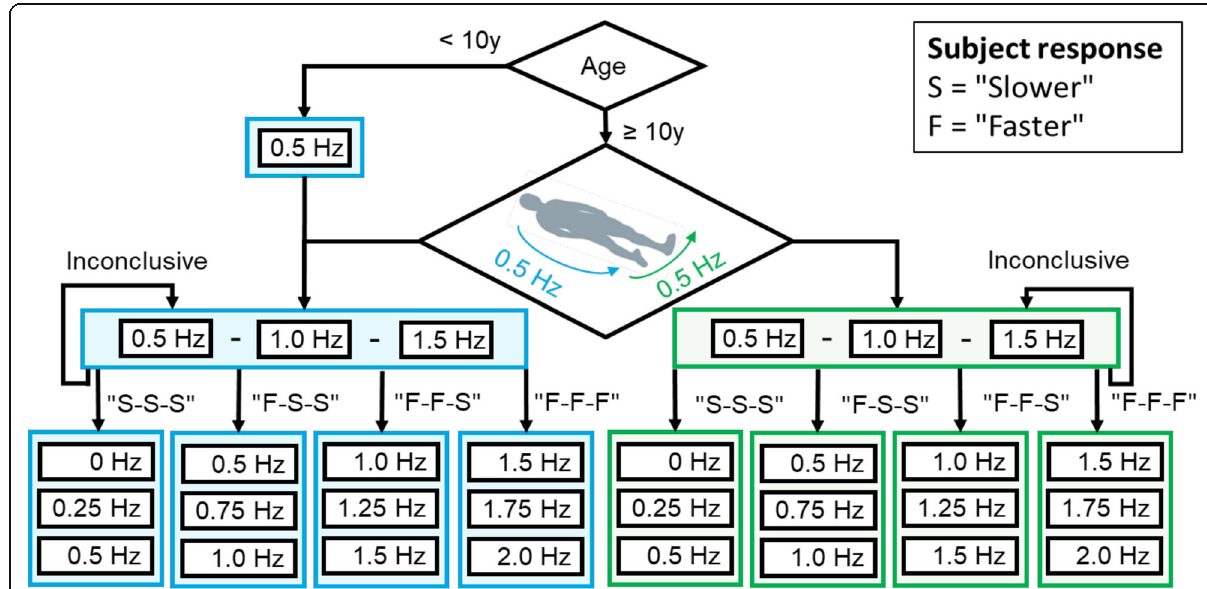
Fig. 1 Stimulation preference selection protocol flow chart. First participants of 10 years and older were presented two motion direction (side-to- side or head-to-toe) while the bed was moving with a frequency of 0.5 Hz, and were asked to choose a preferred direction. For safety reasons participants under 10 years tried only the head-to-toe direction. All participants were then presented three frequencies and were instructed to indicate whether for the bed to promote sleep it should move faster (F) or slower (S). These responses were taken into account to narrow down the stimulation frequency for a second round of three frequencies. All conditions were presented for 1 min. Amplitude and frequency were set to result in a maximum velocity of 0.1 m/s. Outcome of the stimulus preference protocol was a direction and frequency to be used during the intervention